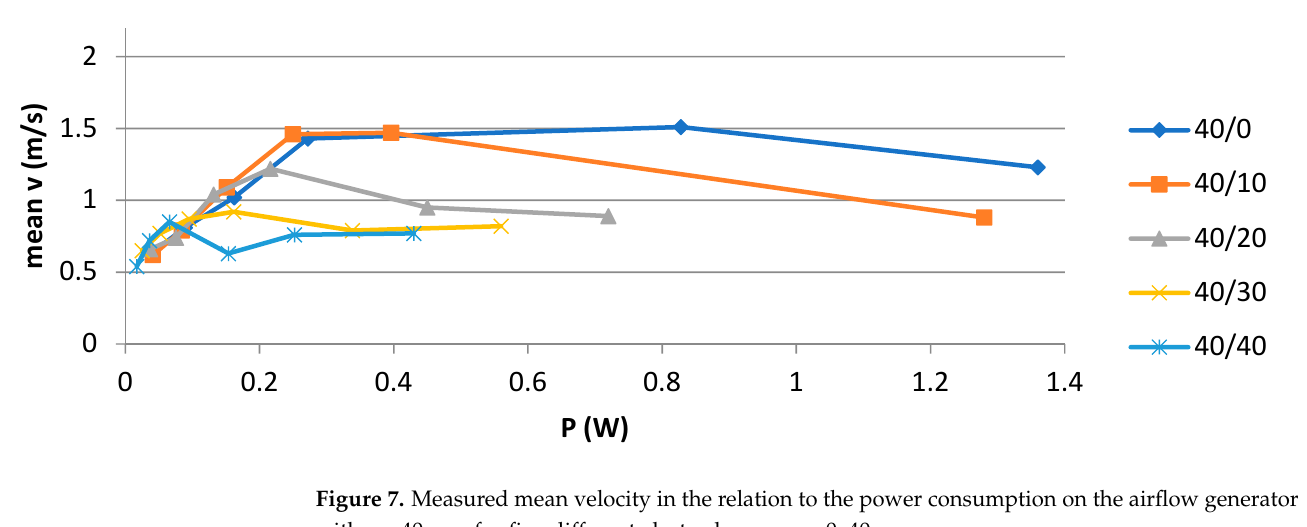
Figure 7. Measured mean velocity in the relation to the power consumption on the airflow generator with a = 40 mm for five different electrode gaps g = 0–40 mm. For the sake of completeness, the V-A characteristic of one of the measured devices (a = 100 mm) with several electrode gaps is also included (see Figure 8). As expected, the typical V-A characteristics of high-voltage corona discharge are shown. Because the device is working in the region of corona discharge only, the V-A characteristic includes the appropriate voltage ranges. For this reason, other discharge modes (e.g., spark discharge, arc) are not included.